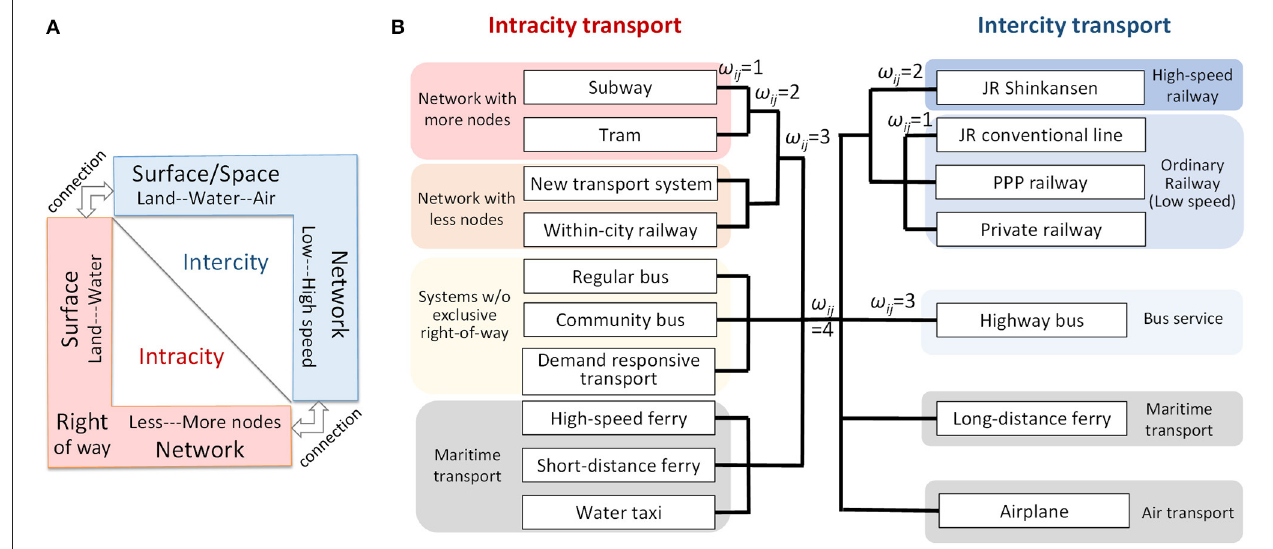
FIGURE 2 | (A) Conceptual model to classify public transport. (B) Definition of taxonomic distance in a hierarchical structure of public